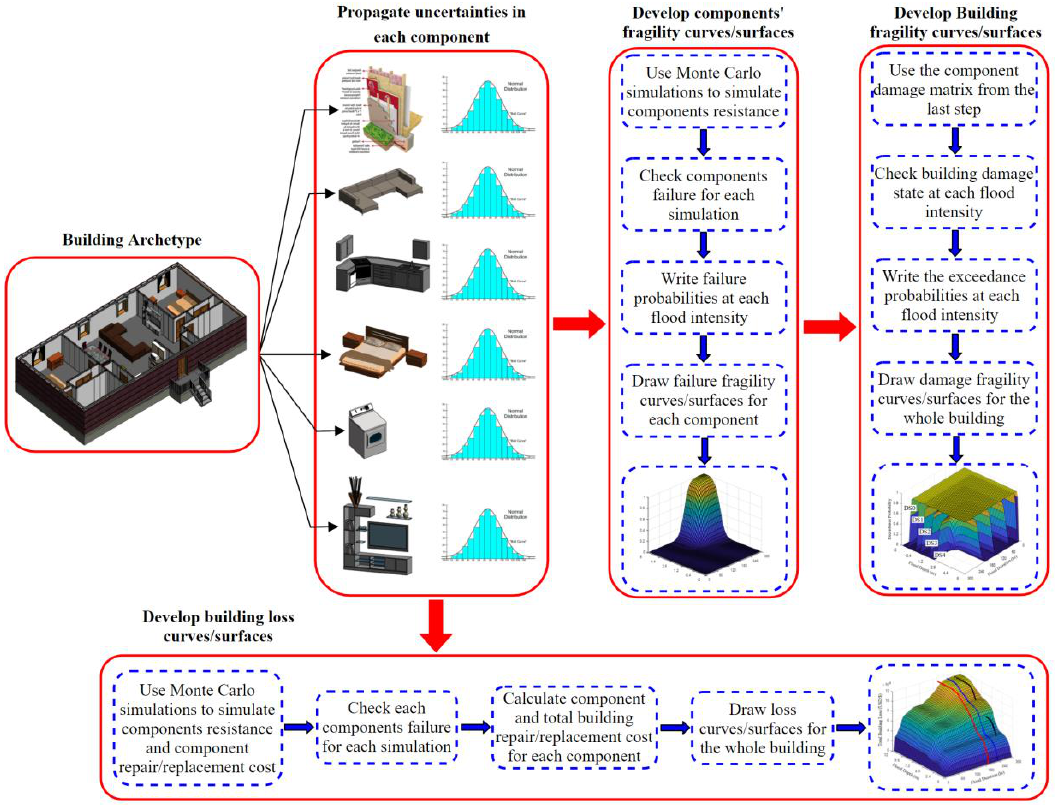
Figure 1. A schematic representation of the methodology that has been applied in this research to account for fragility and loss curves/surfaces for a portfolio of minimal building archetype.